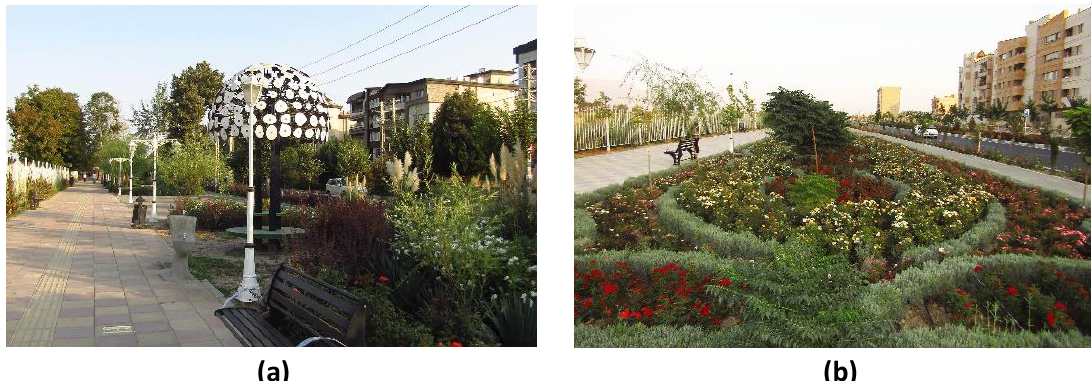
Fig. 5: (a) A statue resembled to flower in white colors in the middle of the green space; (b) An attractive greenery landscaping, resulting in beautiful and creative